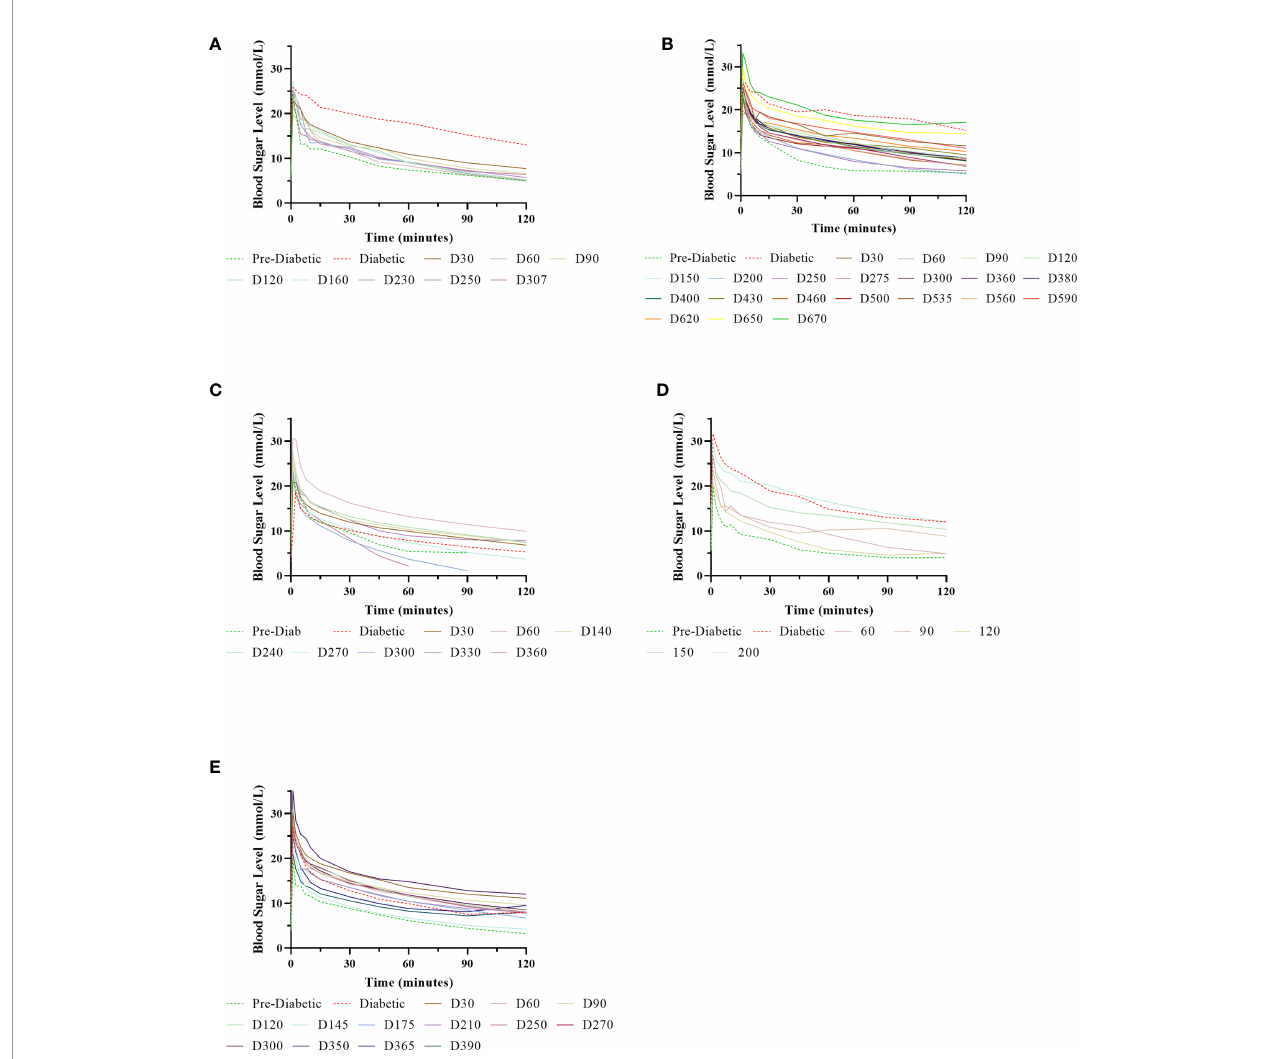
FIGURE 6 | Normalisation of IVGTTs after NICC transplantation. Recipients S1 (A) , B1 (B) , F1 (C) , W1 (D) , O1 (E)